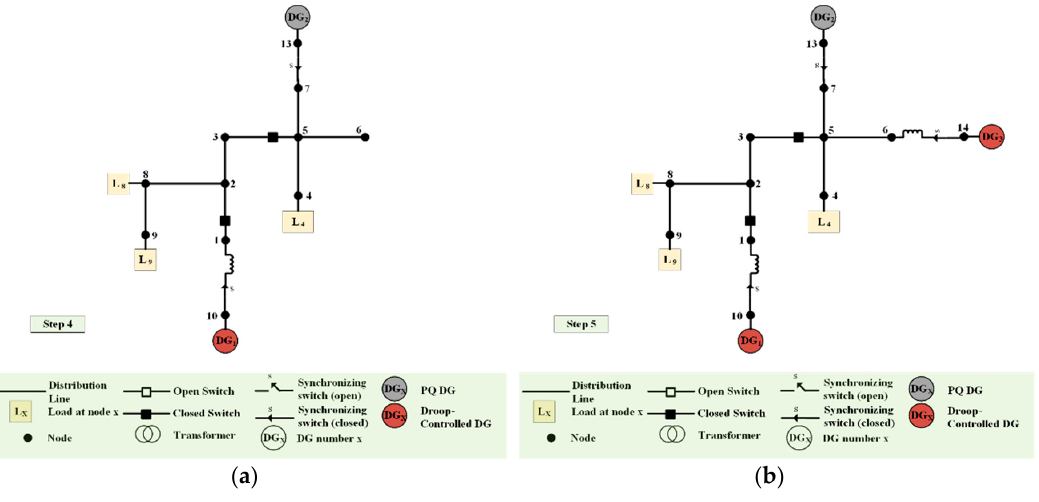
Figure 5. ( a ) Step 4 and ( b ) Step 5 of the Example Restoration Process.